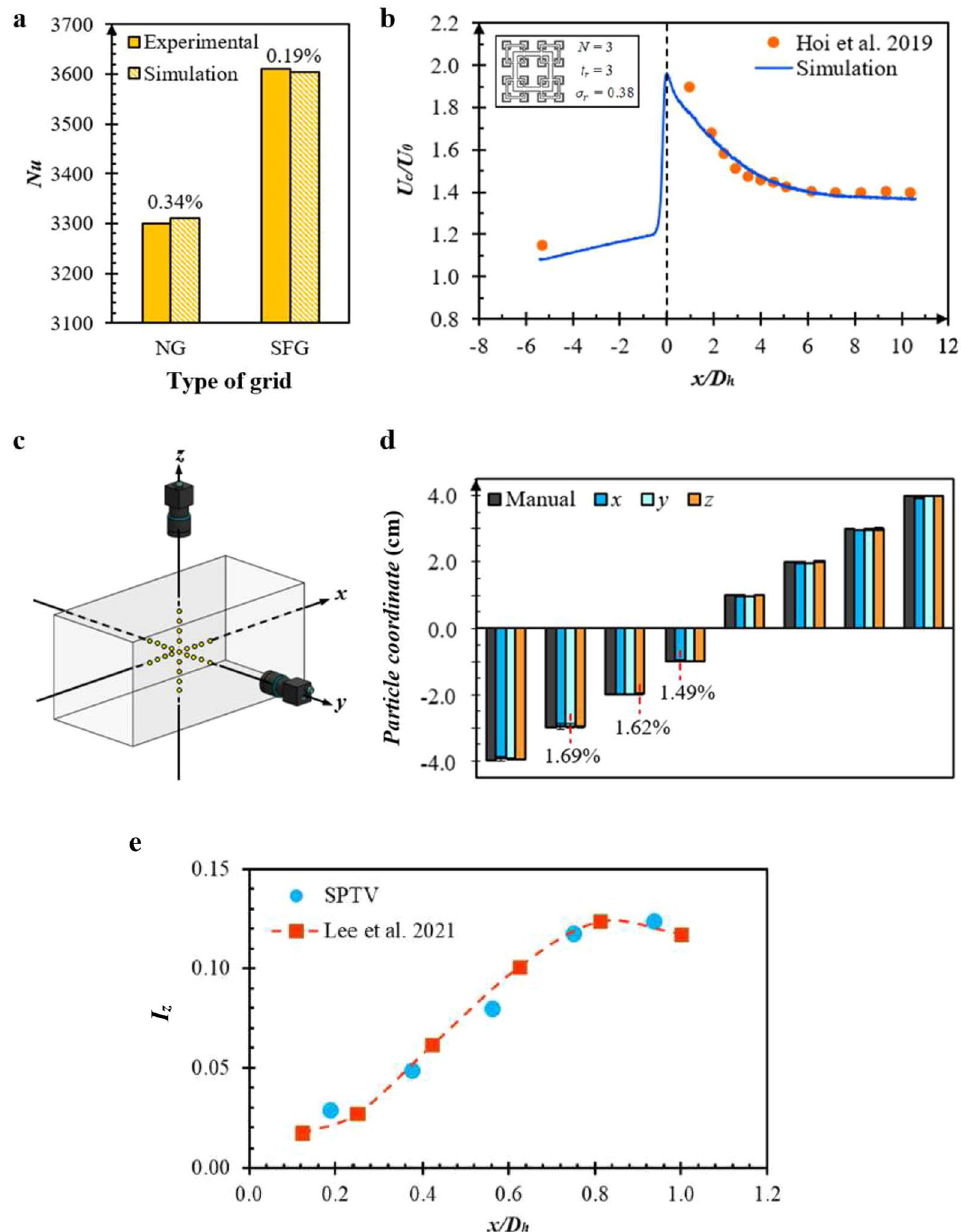
Figure 3. Top, numerical validation of ( a ) Nu for NG and SFG, as well as ( b ) the normalized centreline velocity of fractal grid generated turbulence against Hoi et al. 19,27 experimental data. Middle, ( c ) geometrical representation of particle placements in the wind tunnel test section along with ( d ) the SPTV recorded error margins. Bottom, ( e ) SPTV validation of SFG induced I z against Lee et al. 28 experimental